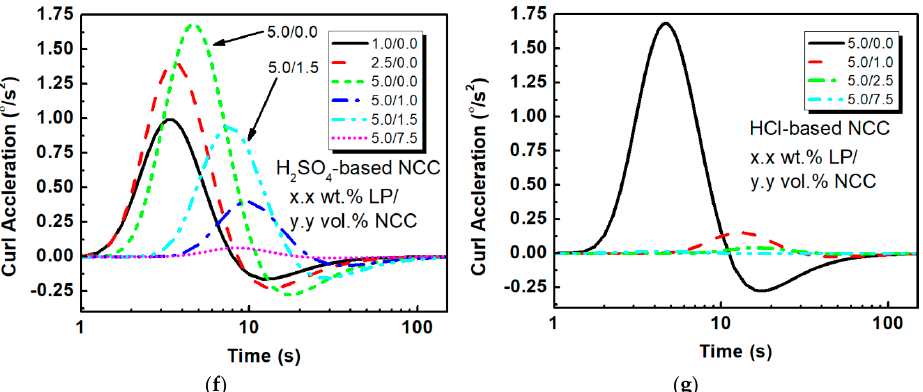
Figure 4. ( a ) Nonlinear and ( b ) linear fitting for PEO–NCC IPMCs utilizing sulfuric acid-based NCC; ( c ) nonlinear fitting for PEO–NCC IPMCs utilizing hydrochloric acid hydrolysis-based NCC; ( d , f ) velocity and acceleration modeling for H 2 SO 4 –NCC composites; ( e , g ) velocity and acceleration modeling for HCl–NCC composites.